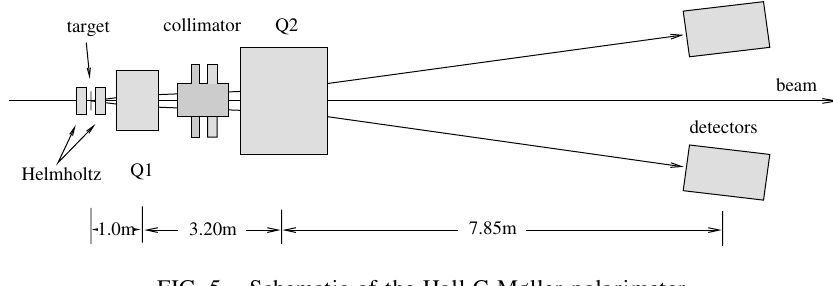
FIG. 5. Schematic of the Hall C Møller